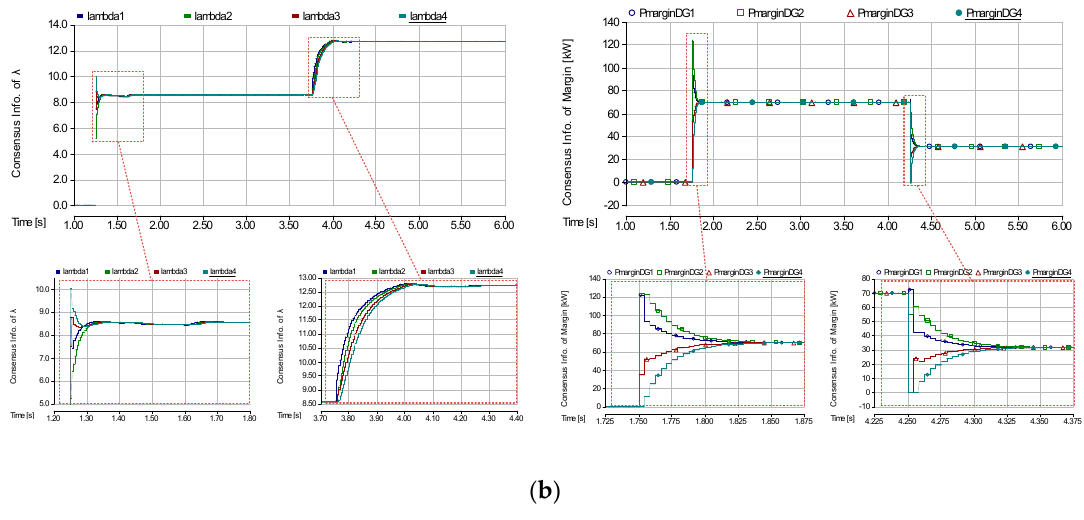
Figure 7. Simulation result in the MG level (Case 1). ( a ) Power of the MG flow, the MG BESS, the DGs and load; ( b ) Convergence of the incremental cost and the power margin of DGs.